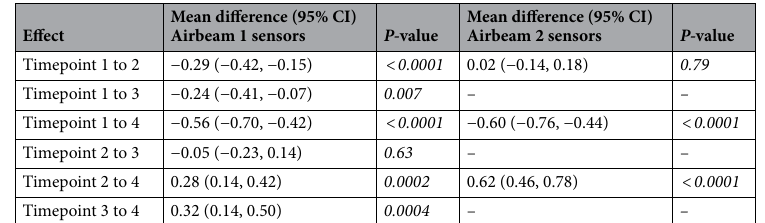
Table 2. Characterization of the least square mean differences for each low-cost particle sensor type over a two-year timeframe, 2019–2021.